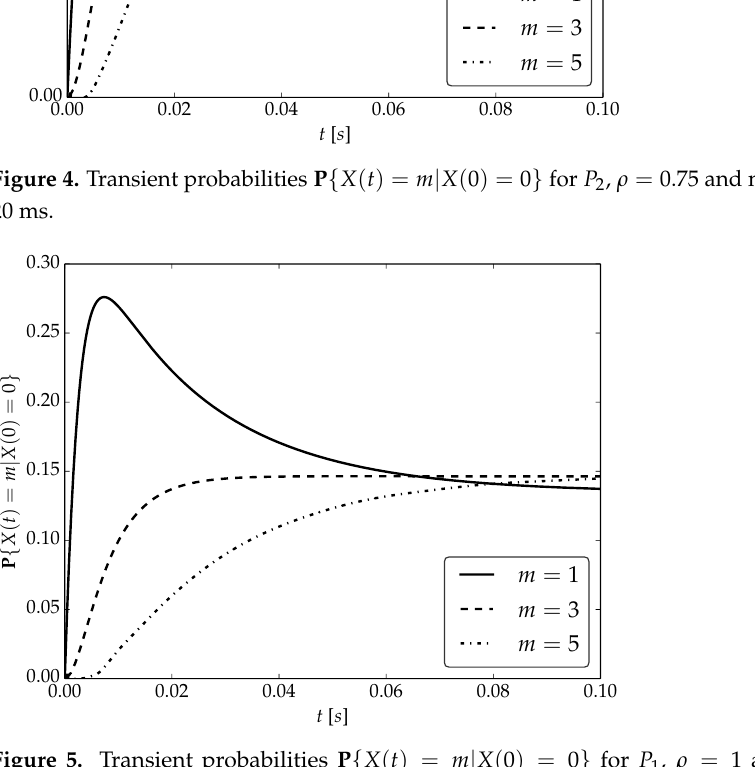
for P 1 , ρ = 1 and mean setup time X ( t ) = m X ( 0 ) = 0 { | }